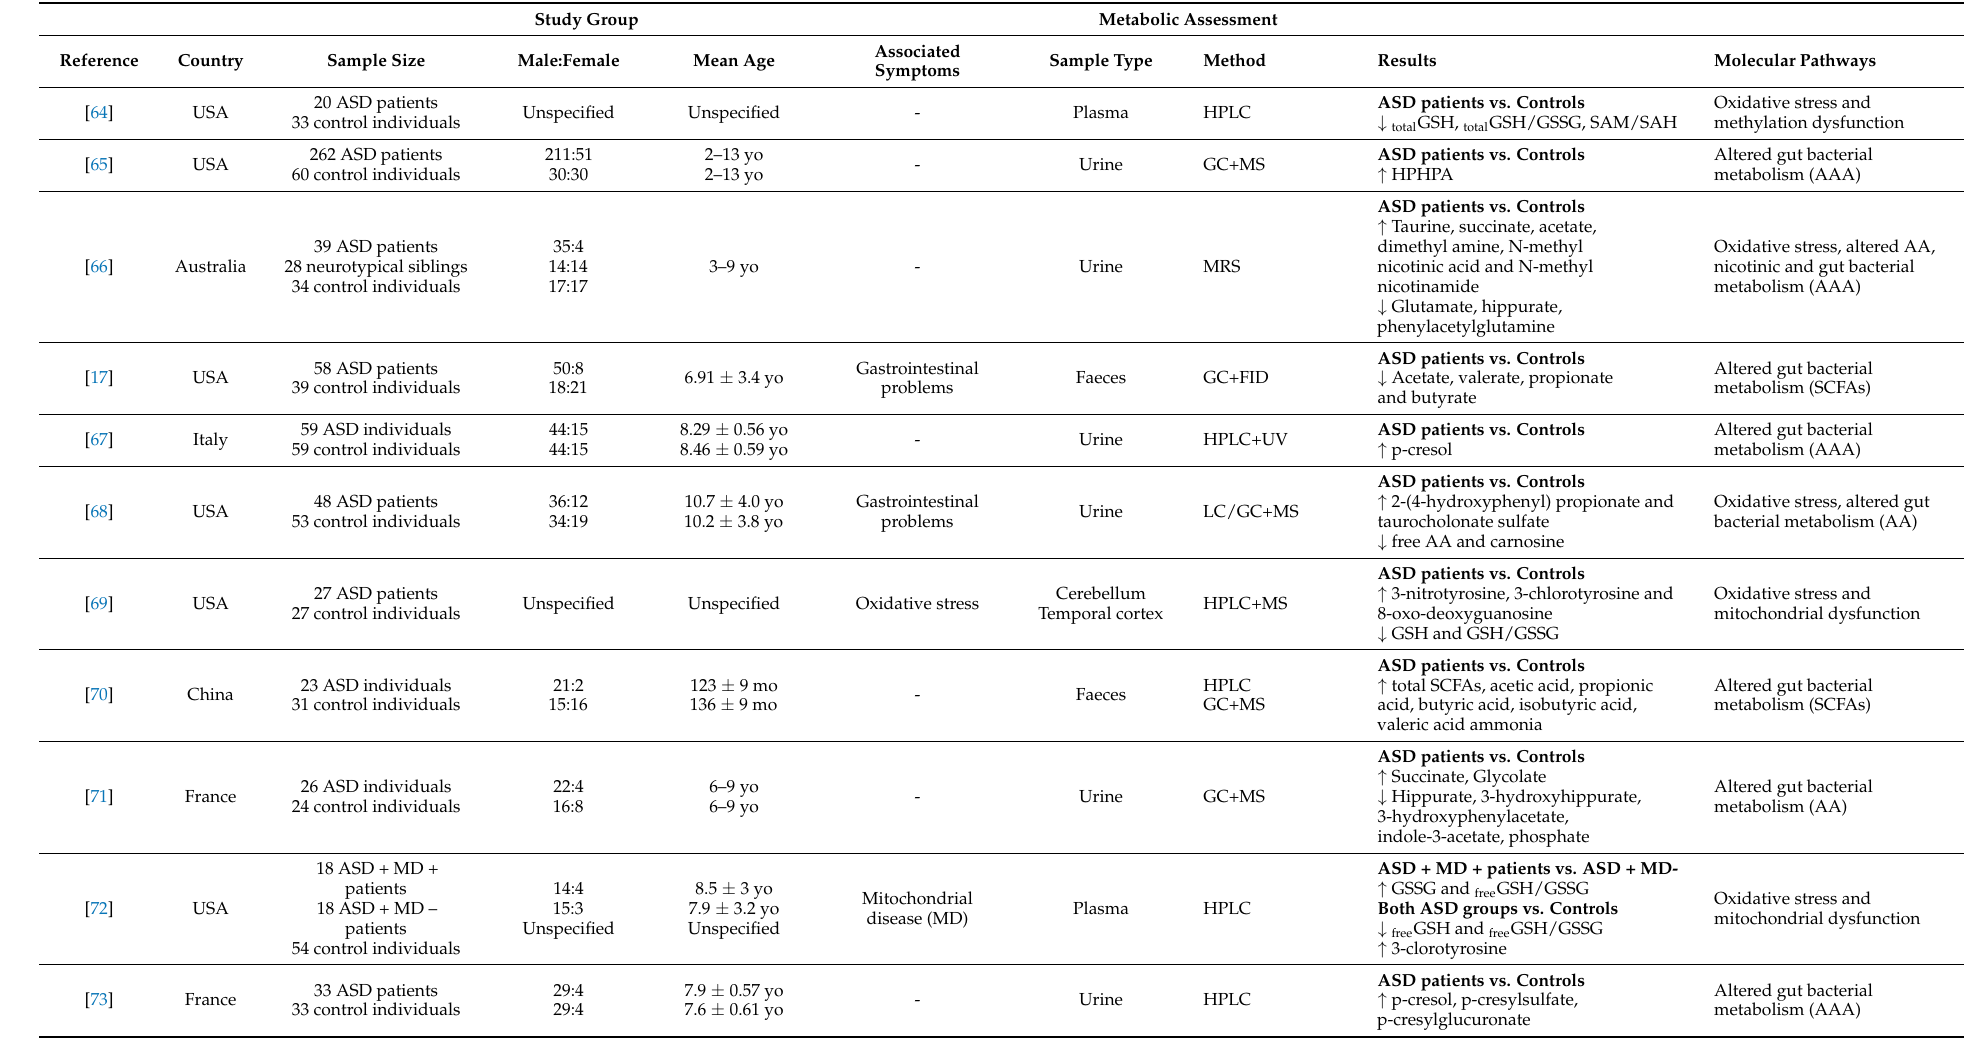
Table 2. Metabolic differences associated with gut microbiota in individuals affected by